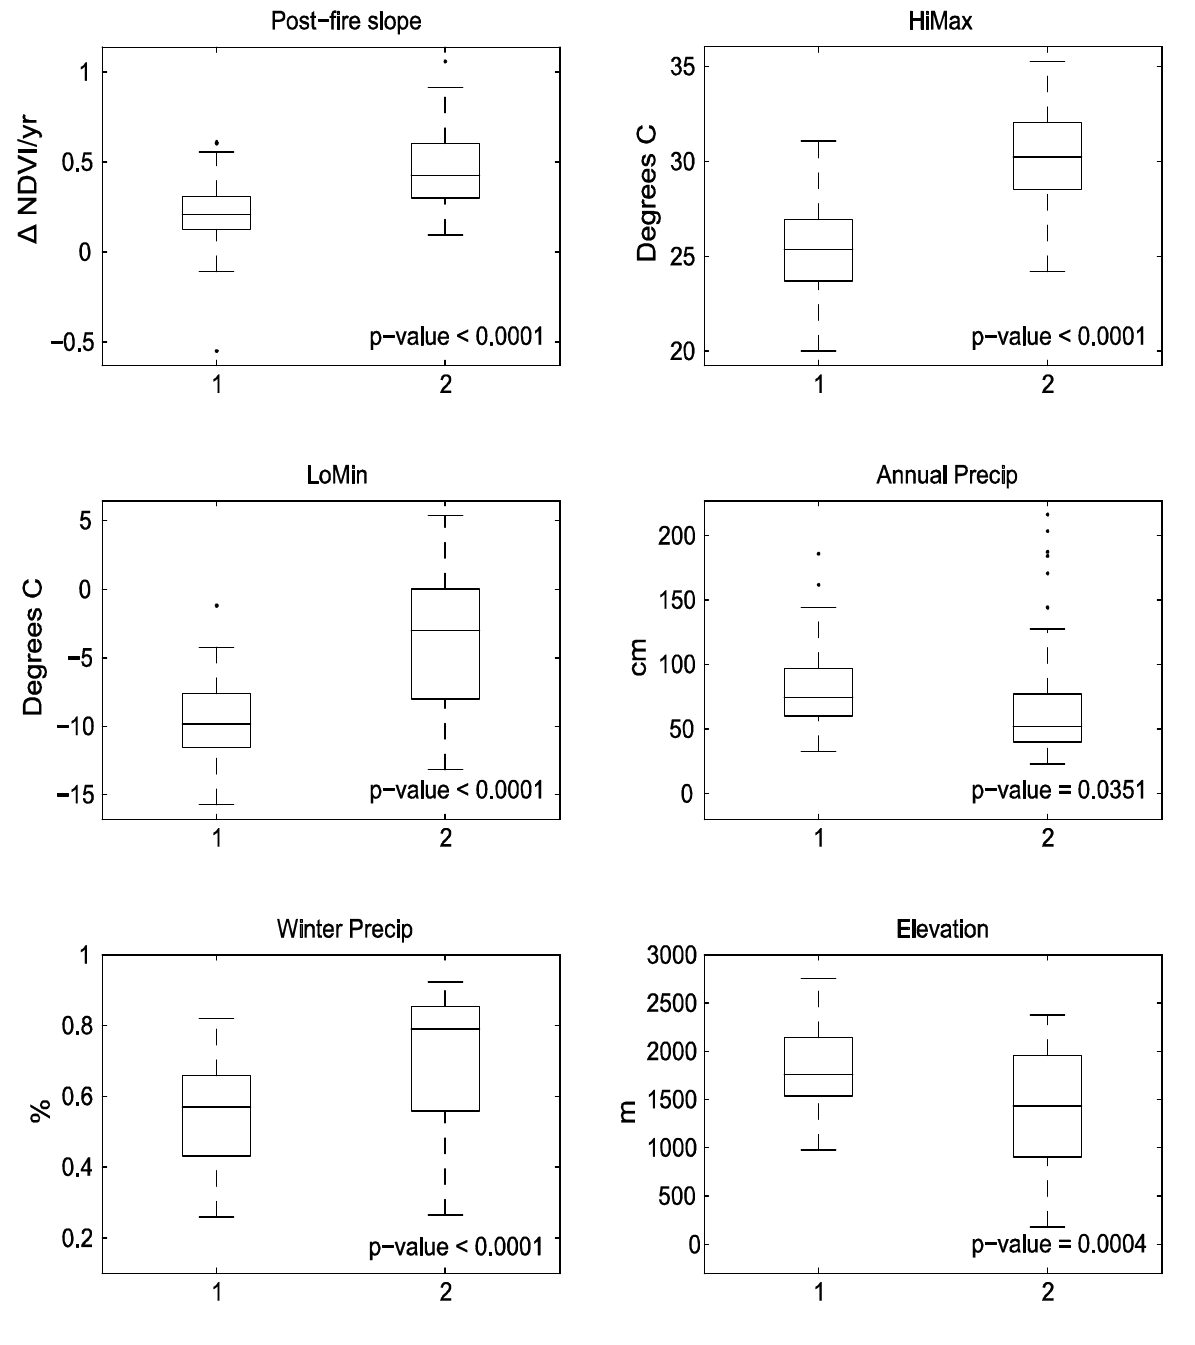
Figure 5. Boxplots showing the differences in regional scale factors and elevation between the two regions delineated using CART analysis. Plots for region one indicate values for Divisions 13, 14, 16, and 28, and plots for region two indicate values for all other Divisions. Significance of the difference between each factor was tested using a t-test with unequal sample sizes, p-values are shown in the lower right corner of each plot. HiMax refers to the annual maximum of the monthly maxima for the 30 year average temperature, and LoMin refers similarly to the minimum of the monthly